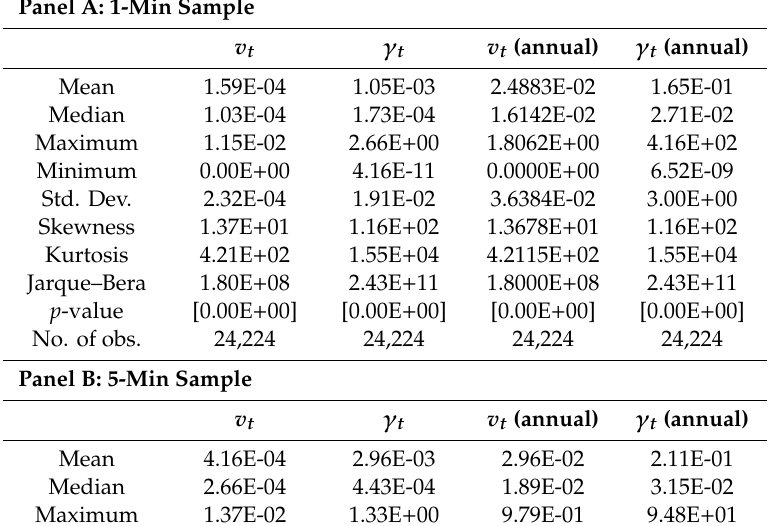
Table 1. Descriptive statistics for volatility and the volatility of volatility of the S&P 500. Panel A: 1-Min